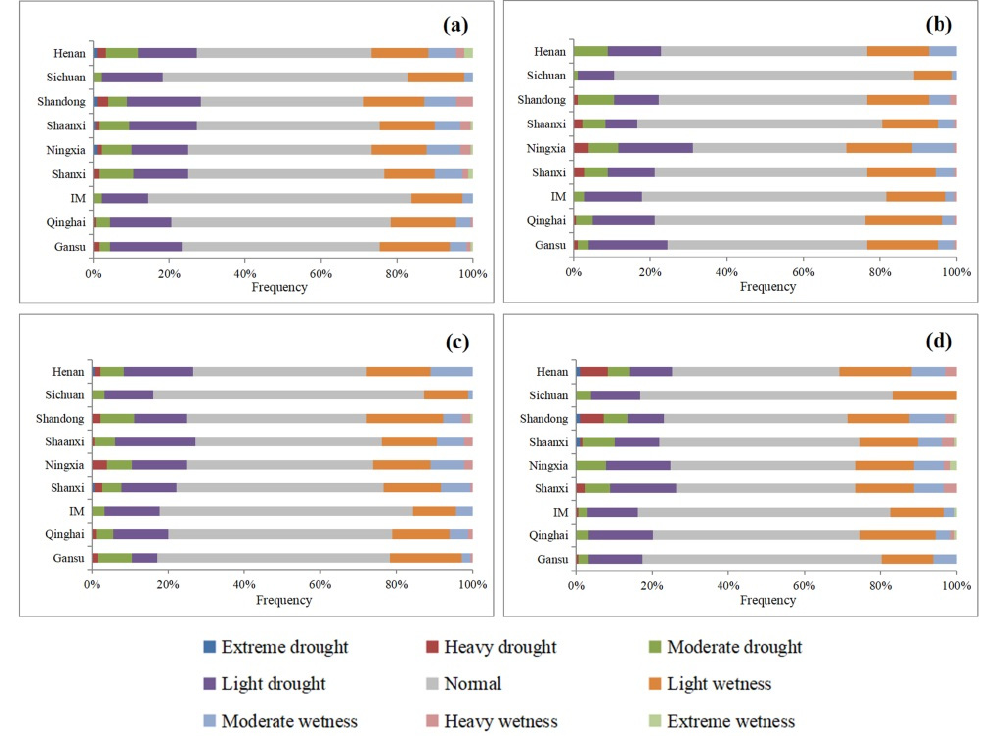
Figure 4. Characteristics of drought and wetness in spring ( a ), summer ( b ), autumn ( c ), and winter ( d ) in the Yellow River basin.